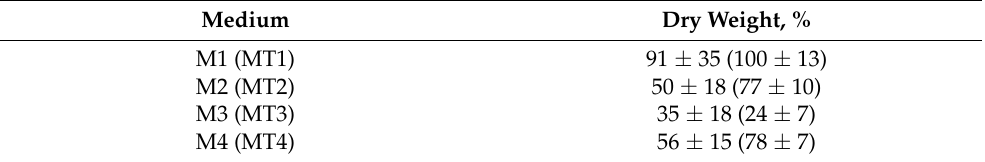
Table 1. Trichoderma asperellum dry weight (%) from the flask experiment. One hundred percent— highest biomass reached in experiment. The percentage of other biomasses was adjusted respec- tively to the highest value. Medium designations: M1—malt extract medium, M2—yeast extract